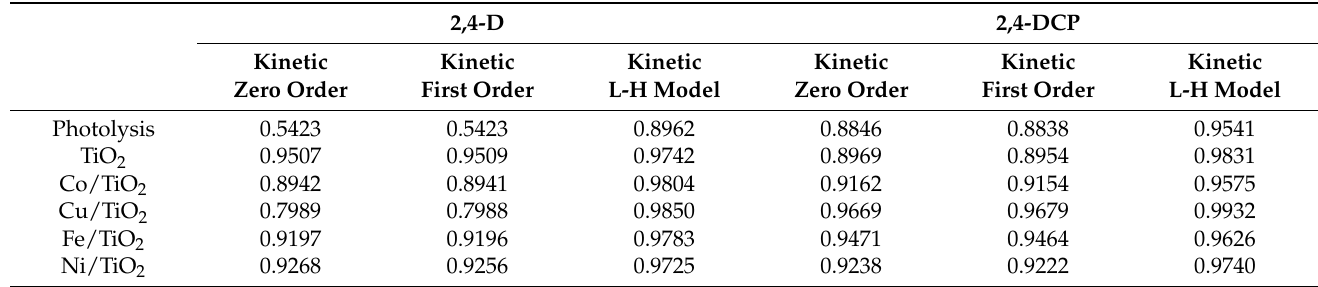
Table 4. Coefficient of correlation of first-order kinetic equation, coefficient of correlation of zero-